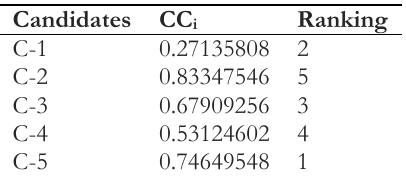
Table 14. The similarity coefficients (CCi) and the ranking of the candidates according to the worst similarity for the time span of Y25-Y30 (with the behavior change of candidates 1 and 5).